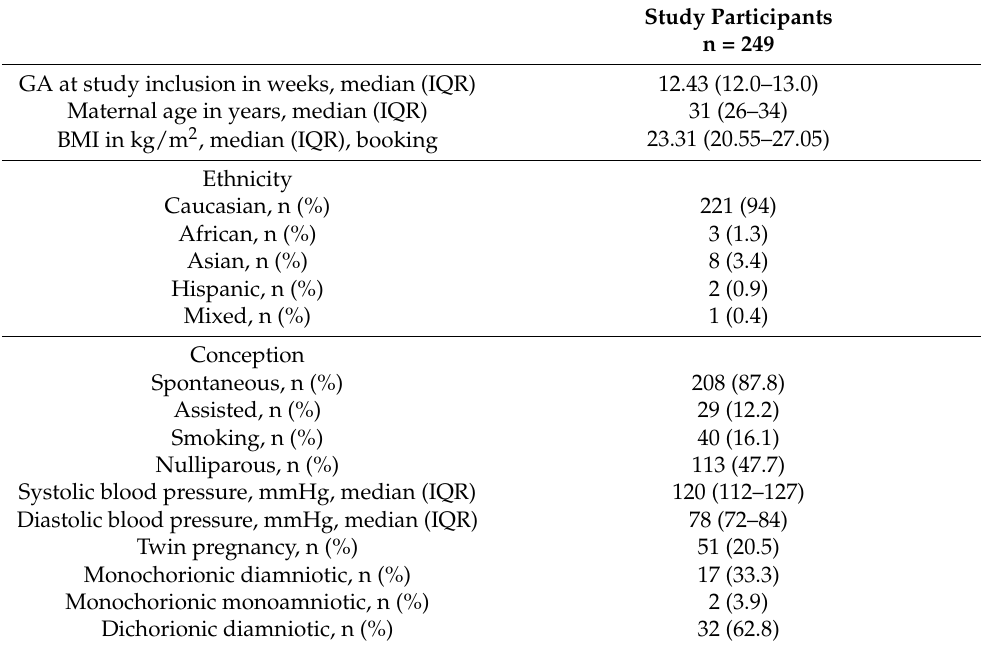
Table 1. Patient characteristics (singleton and twin